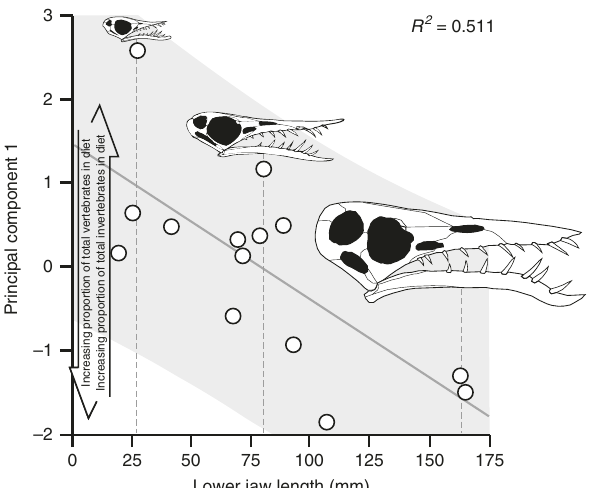
Increasing proportion of total vertebrates in diet Increasing proportion of total invertebrates in diet